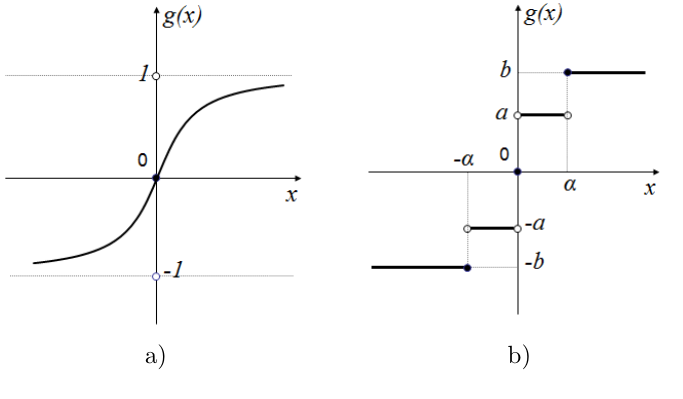
arctan x , b) step signal π